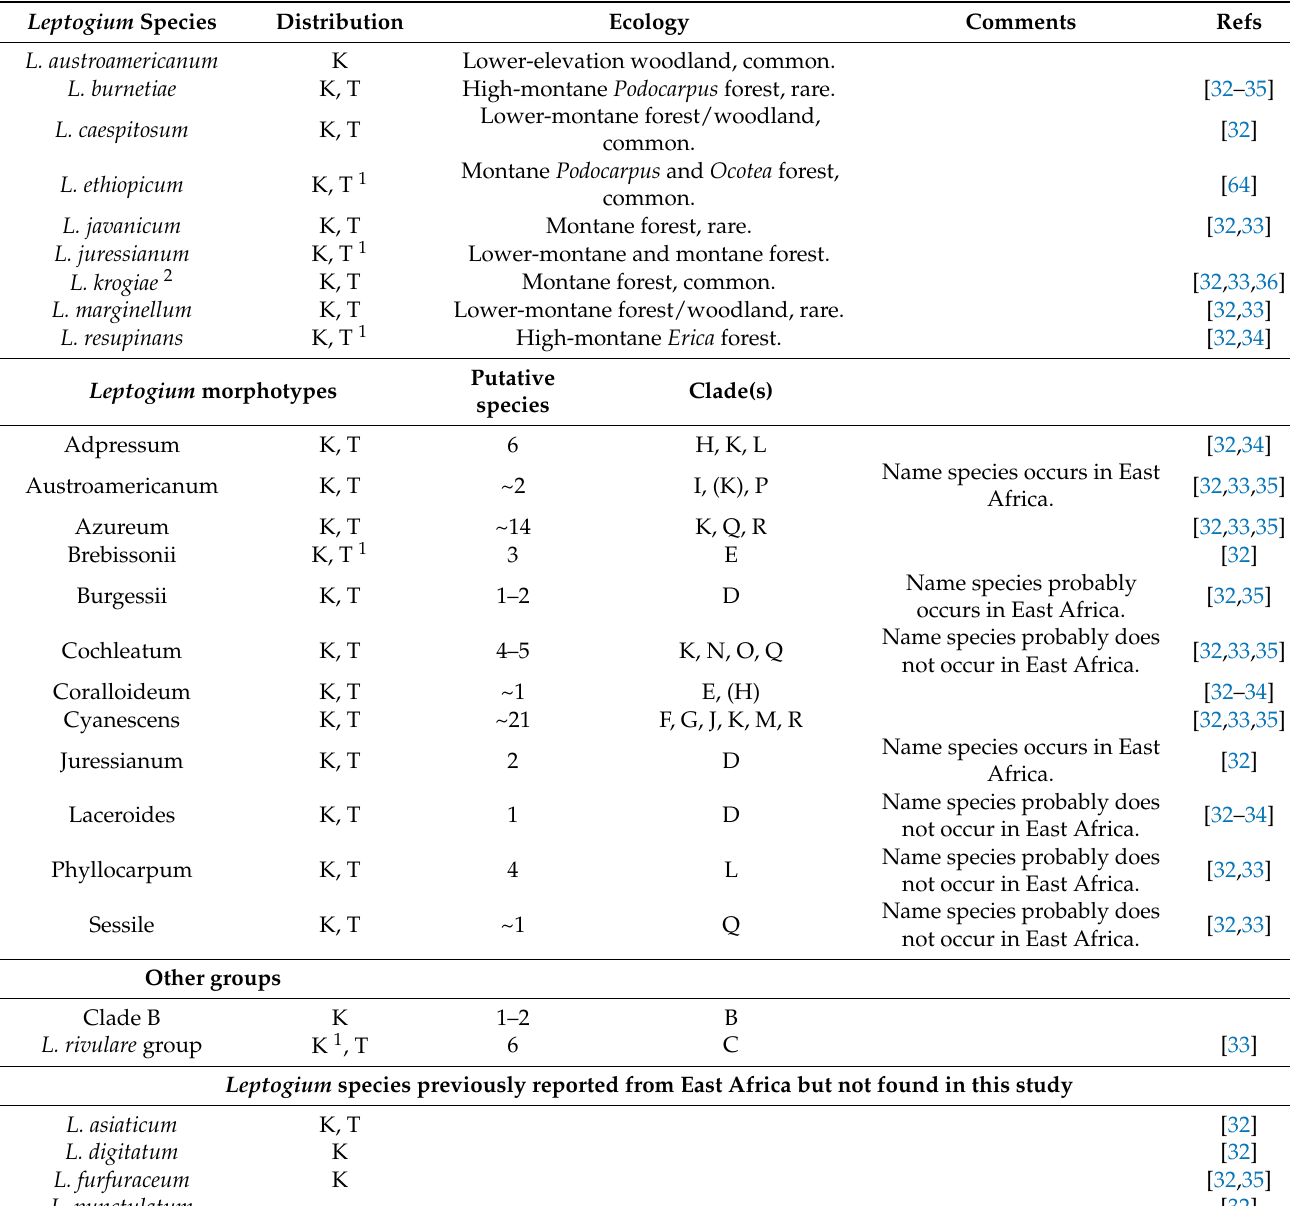
Table 1. Diversity of the genus Leptogium in the study area. The distribution in Kenya (K) and Tanzania (T) also includes previous literature reports (Refs); if more than one morphologically similar taxa are present in the region the previous reports are listed after Leptogium morphotypes. Ecology is reported as observed in this study. Leptogium Species Distribution